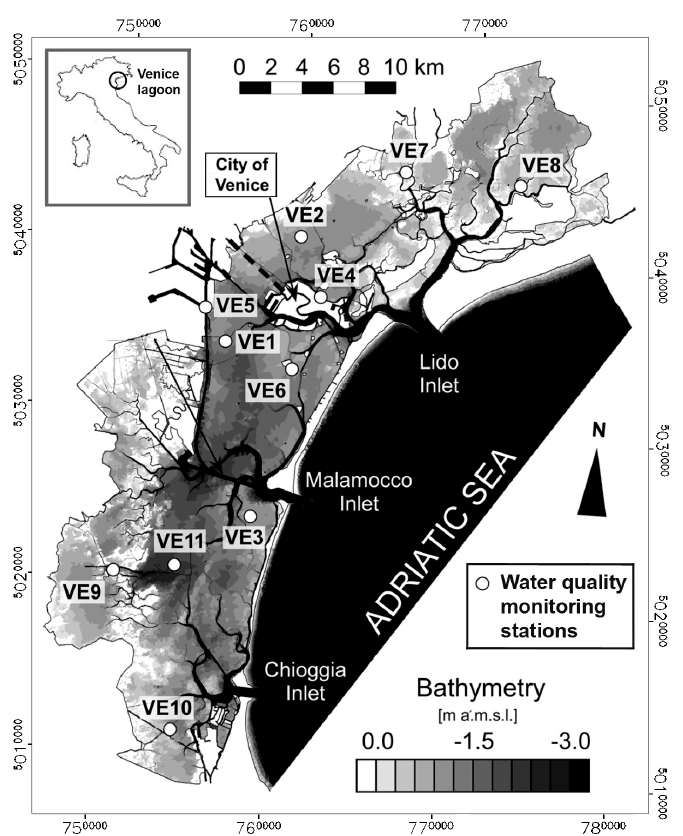
Figure 1. Bathymetric map of the Venice lagoon showing the location of the 10 measurement stations (white circles, VE1 to VE10), modified after [24]. The Venice lagoon is located within the black circle on the map of Italy on the upper left.